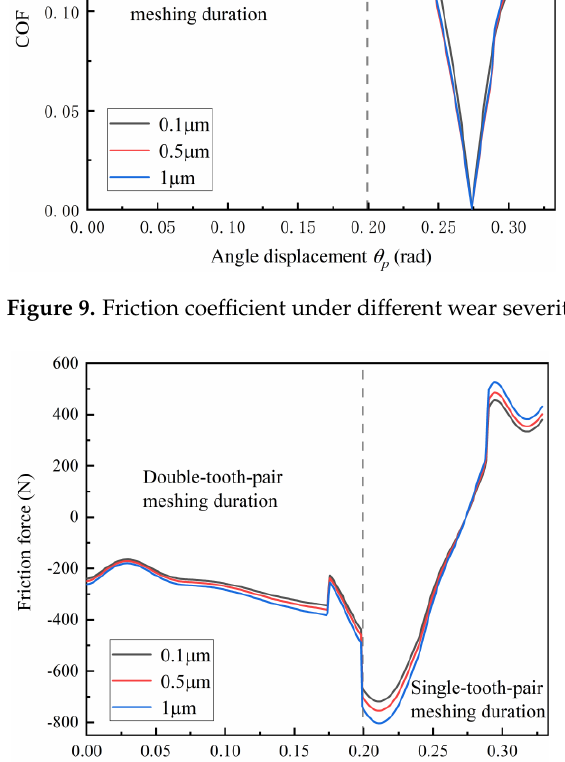
Figure 10. Friction force under different wear severities.